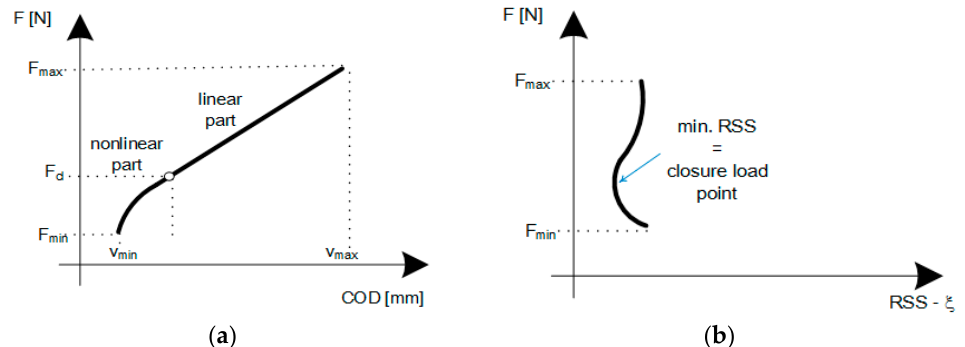
Figure 6. Simplified decomposition of the registered F (Force)-COD (Crack Opening Displacement) signal [9,10].